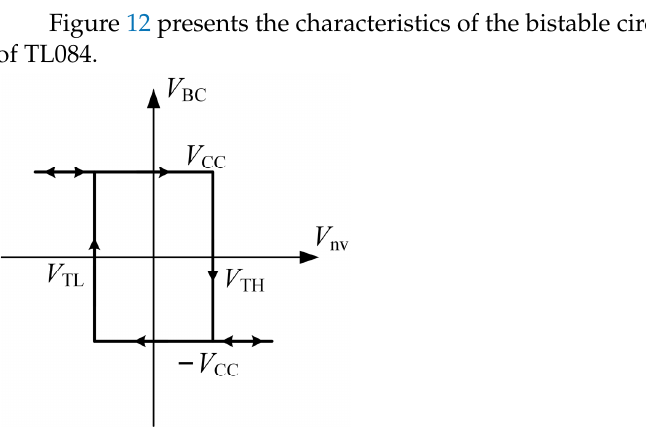
Figure 12. Characteristics of the bistable circuit composed of part B of TL084.